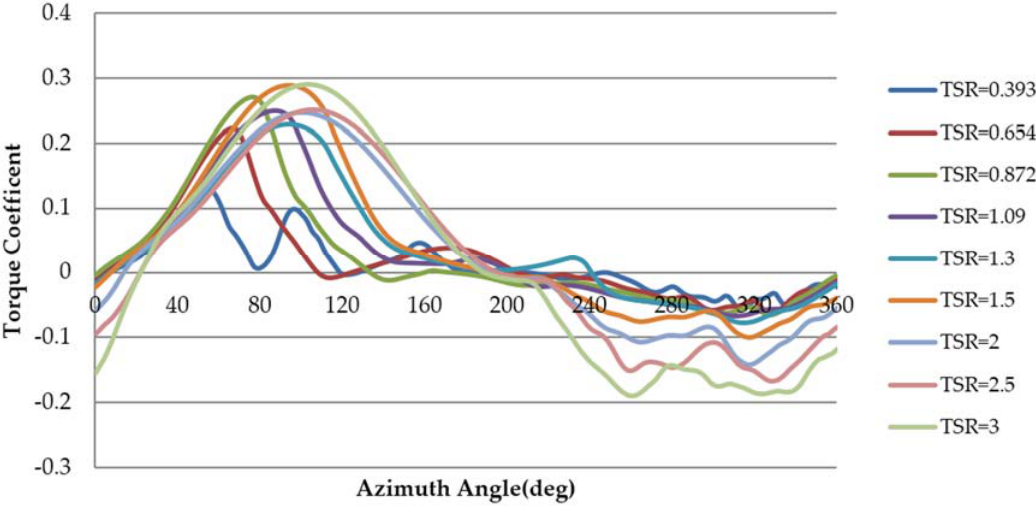
Figure 17. Torque coefficient variation in different TSR .